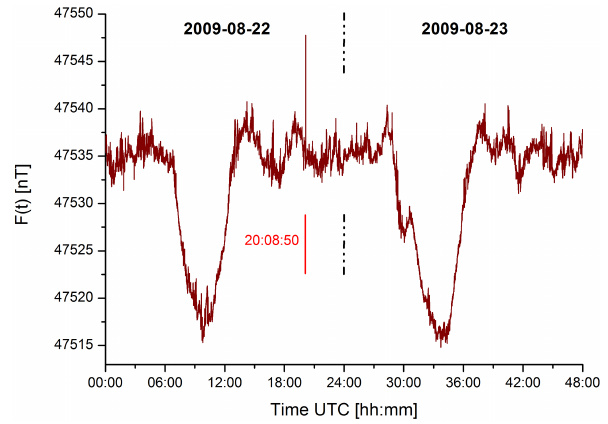
Figure 1. Daily variation of the geomagnetic field F(t) at Sinji Vrh on two successive days in the summer of 2009.